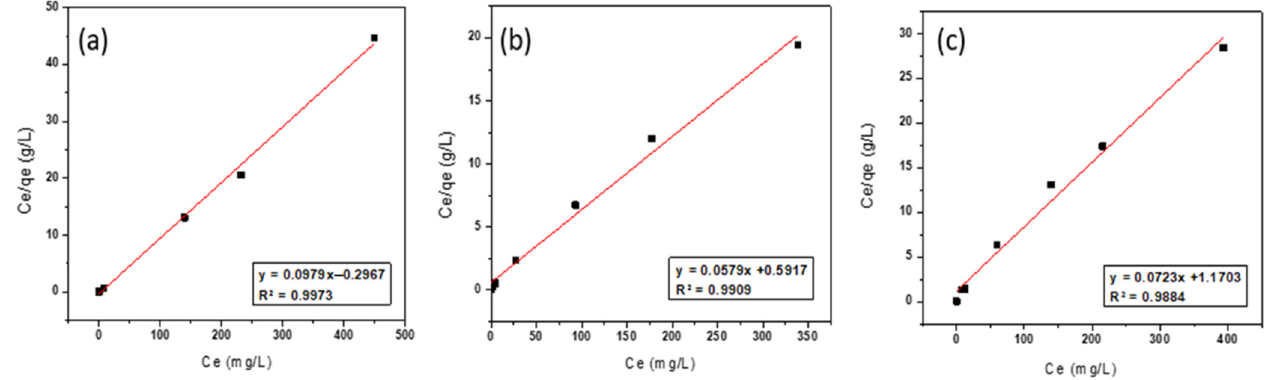
Figure 10. Langmuir isotherm model of thorium adsorption onto ( a ) NZ, ( b ) PZ, and ( c ) SZ. Table 5. Isotherm parameters and the correlation coefficient values (R 2 ) for the adsorption of thorium onto NZ, PZ, and SZ.